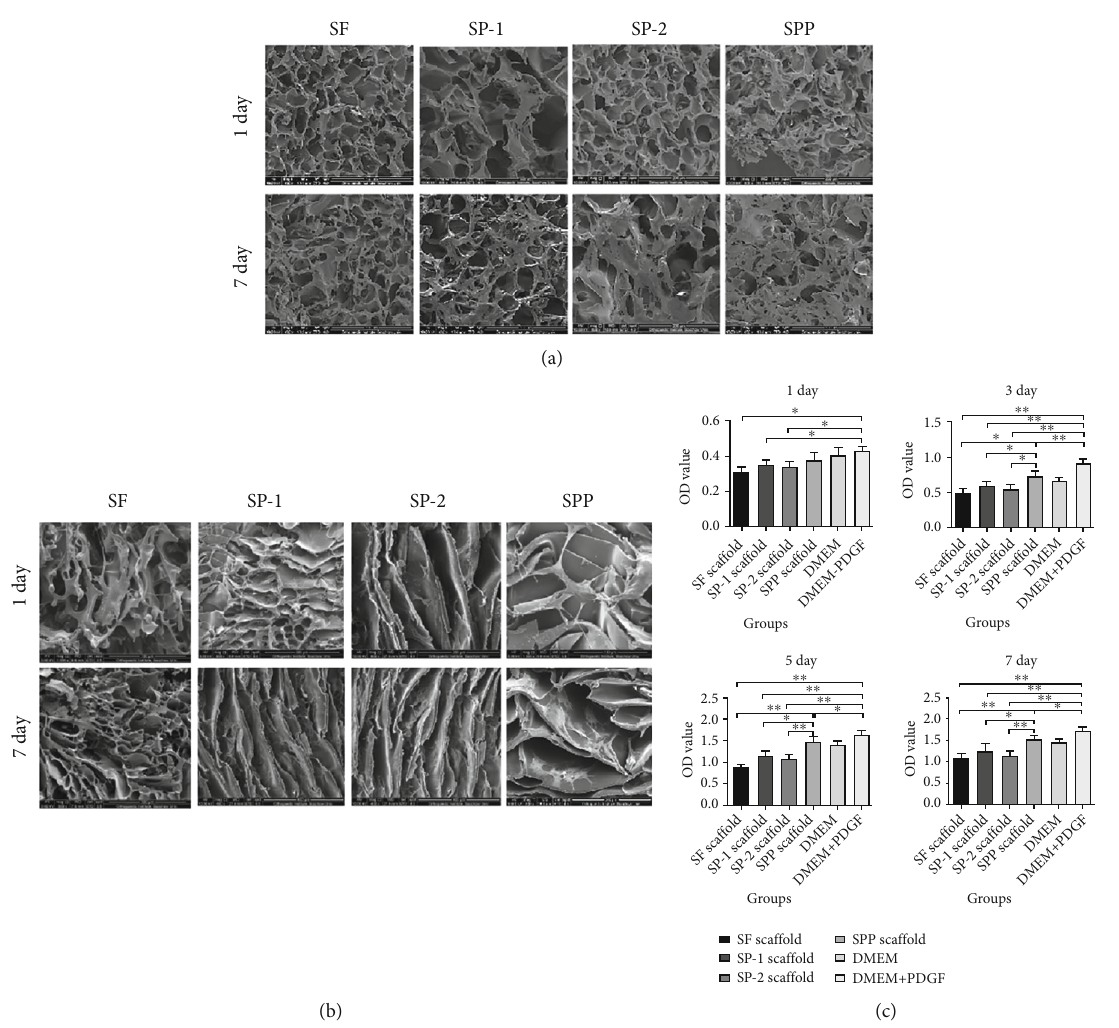
Figure 4: Cell adhesion and proliferation assays of di ff erent sca ff olds. (a) SEM images of SMSCs adhesion on cartilage phase of sca ff old loaded with or without PDGF or PDA after seeding for 1 d and 7 d. (b) SEM images of SMSC adhesion on interface layer of sca ff old after seeding for 1d and 7 d. (c) Cell proliferation of SMSCs cultured on di ff erent sca ff olds after 1d, 3 d, 5d, and 7d using a CCK-8 kit. Statistically signi fi cant di ff erences are indicated with ∗ P < 0 : 05 and ∗∗ P < 0 : 01 compared with